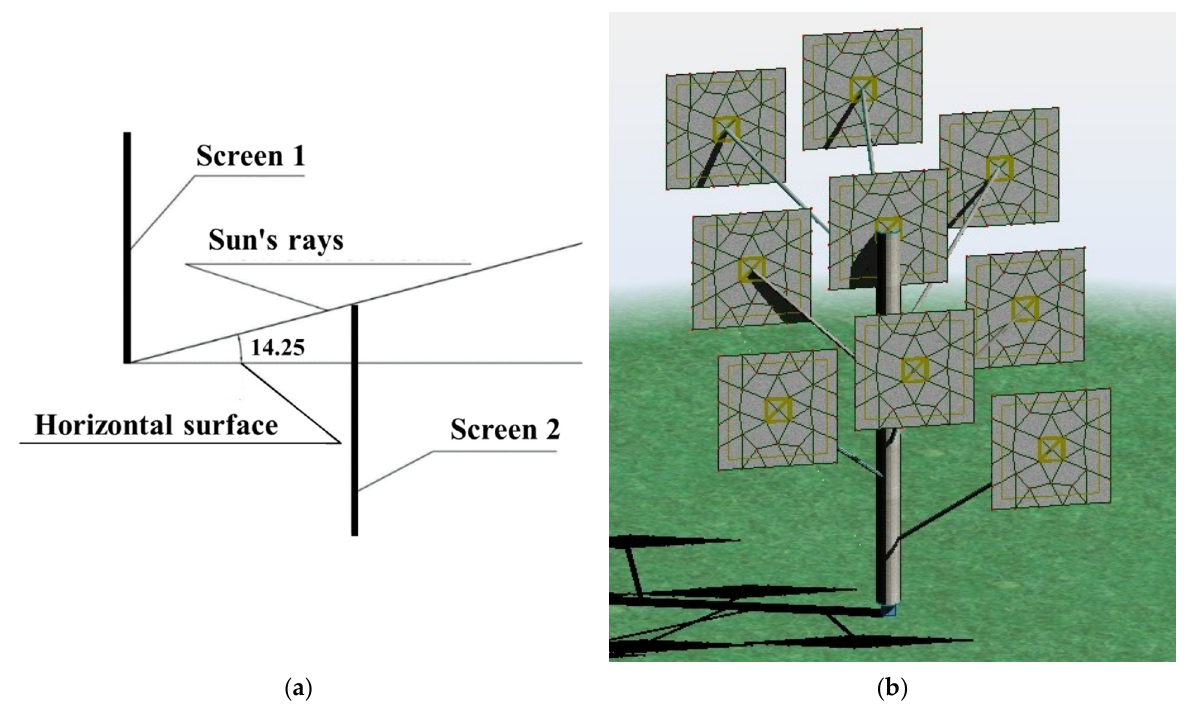
Figure 6. Model of the arrangement of screens [77]: ( a ) the influence of mutual shadow of screens and their free movement in relation to each other; ( b ) the model of the supporting structure for photovoltaic screens in Auto-desk Robot Structural Analysis Professional.